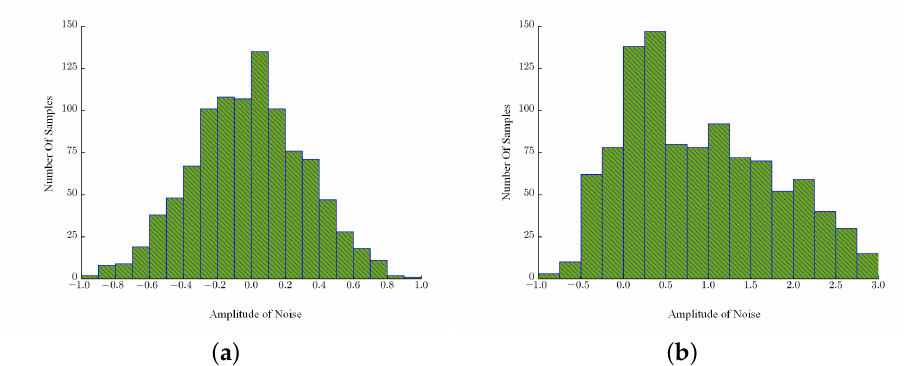
Figure 5. Amplitude distribution histogram of compound noise. − 1 ( a ) Histogram of Gaussian noise distribution. ( b ) Histogram of Gaussian mixture noise distribution.